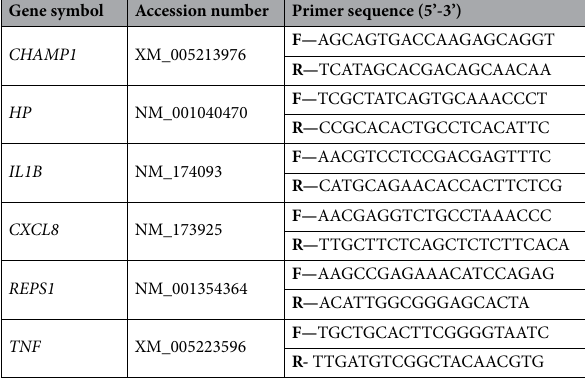
Table 5. Primer sequences used for qPCR analyses of inflammatory